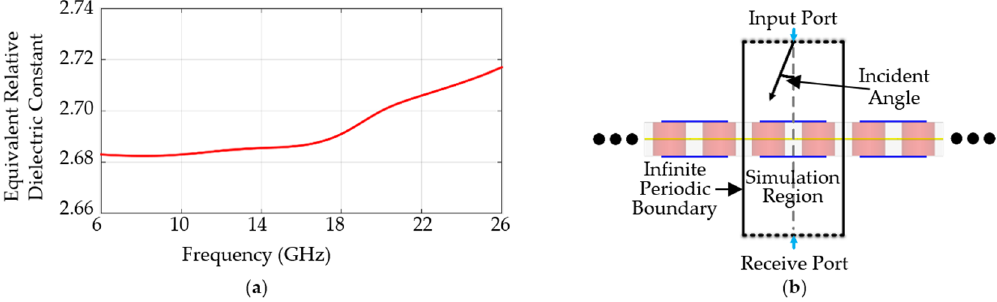
Figure 2. ( a ) The equivalent relative dielectric constant of the PM; ( b ) the schematic diagram of the FSS unit in infinite periodic boundary simulation.